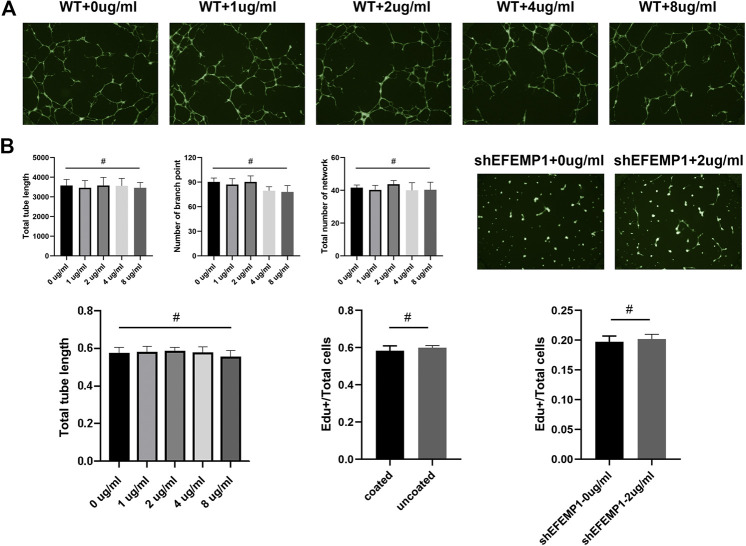
Origin of the proangiogenesis property of EFEMP1. (A) Tube formation of wild type (WT) HUVECs treated with different concentrations (0 µg/ml, 1 µg/ml, 2 µg/ml, 4 µg/ml, and 8 µg/ml) of recombinant human fibulin-3 protein and shEFEMP1 HUVECs treated with or without fibulin-3 protein was tested. (B) Proliferation of wild type (WT) HUVECs treated with different concentrations (0 µg/ml, 1 µg/ml, 2 µg/ml, 4 µg/ml, and 8 µg/ml) of recombinant human fibulin-3 protein, WT HUVECs in fibulin-3 coated or uncoated plates, and shEFEMP1 HUVECs treated with or without fibulin-3 protein was tested using EdU assay. #
p > 0.05.